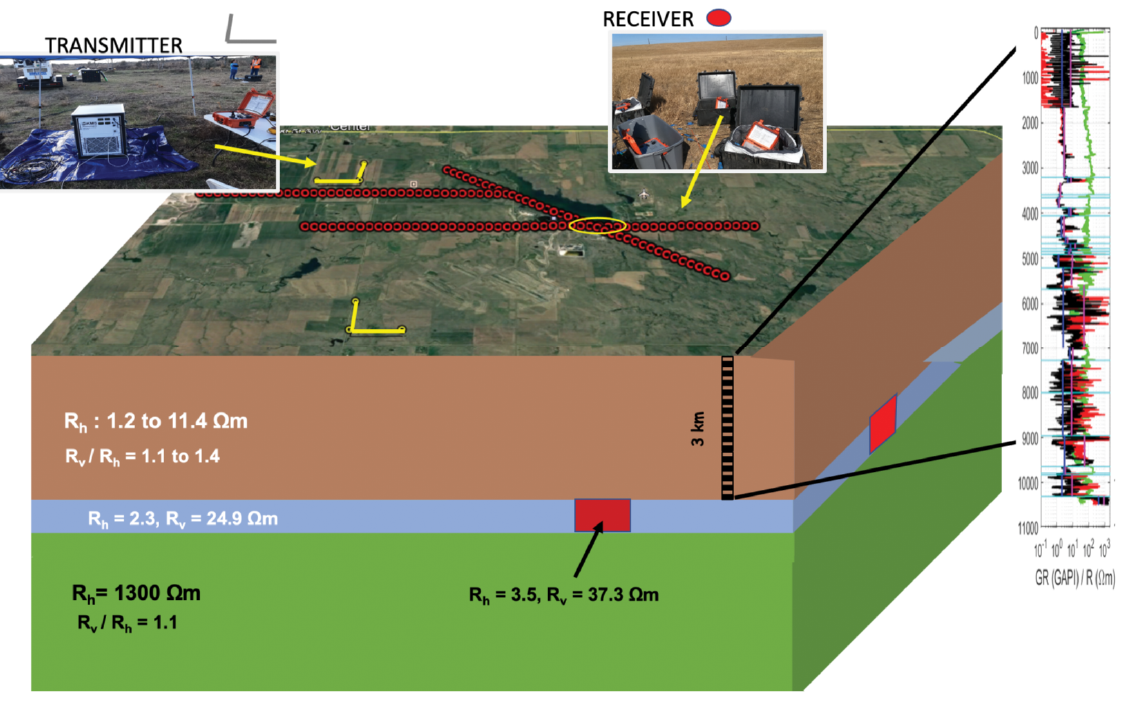
Figure 2. Survey layout for a controlled source EM (CSEM) system showing four transmitter locations (yellow lines) and three receivers’ lines (red circles). At each location all electromagnetic components are being recorded (after [2]). The yellow circle in the center marks the surface projection of the flooded reservoir below that has its outline projected to the red squares on the sides. The numbers represent the Earth model resistivities (R v and R h are vertical and horizontal resistivities respectively). On the right is the borehole data (Gamma ray—GR (green) and resistivity—R (black), invasion zone (red), seismic horizon boundaries (cyan)). The blocky curves through the log are upscaled resistivities building the anisotropic model. Rv and Rh are marked with magenta and blue lines on the